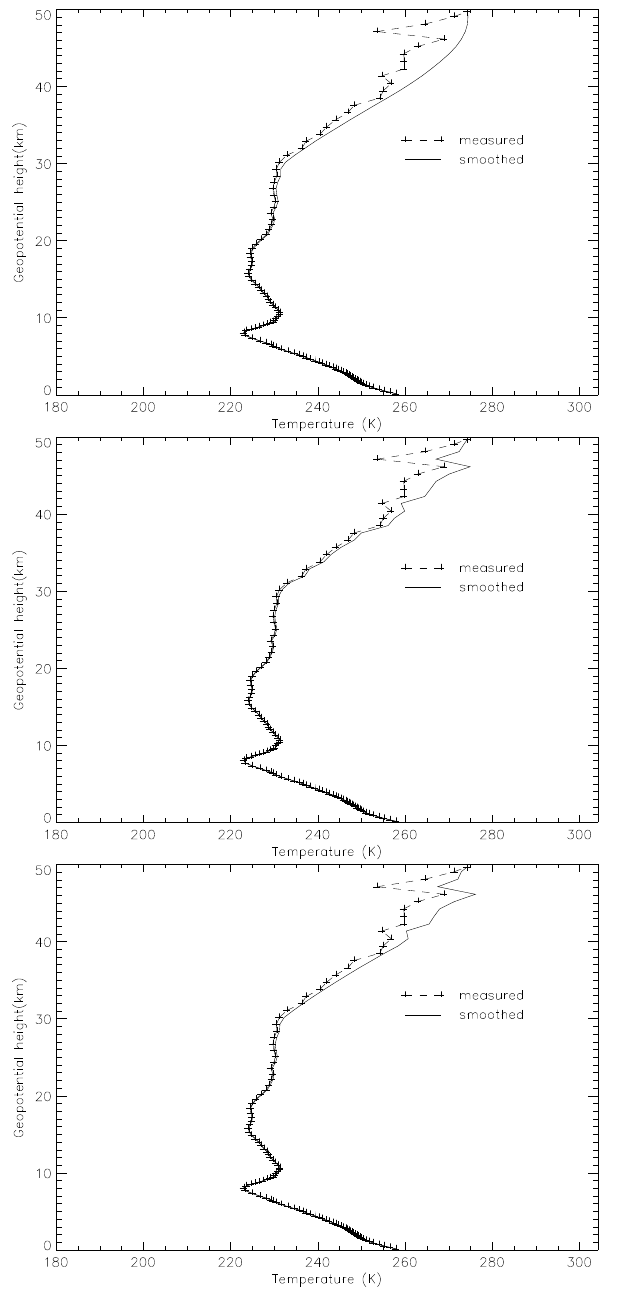
Fig. 4. The retrieved temperature profiles corresponding to the smoothed bending angle profiles given in Fig. 1.